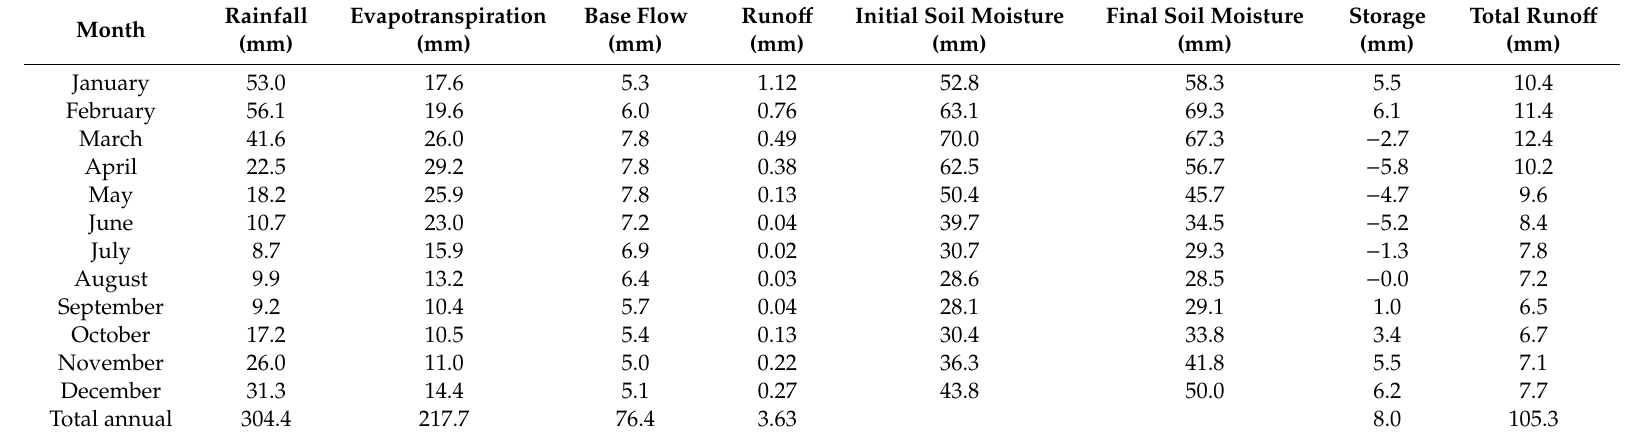
Table 3. Average Multi-annual Monthly Water Balance of the Study Area.